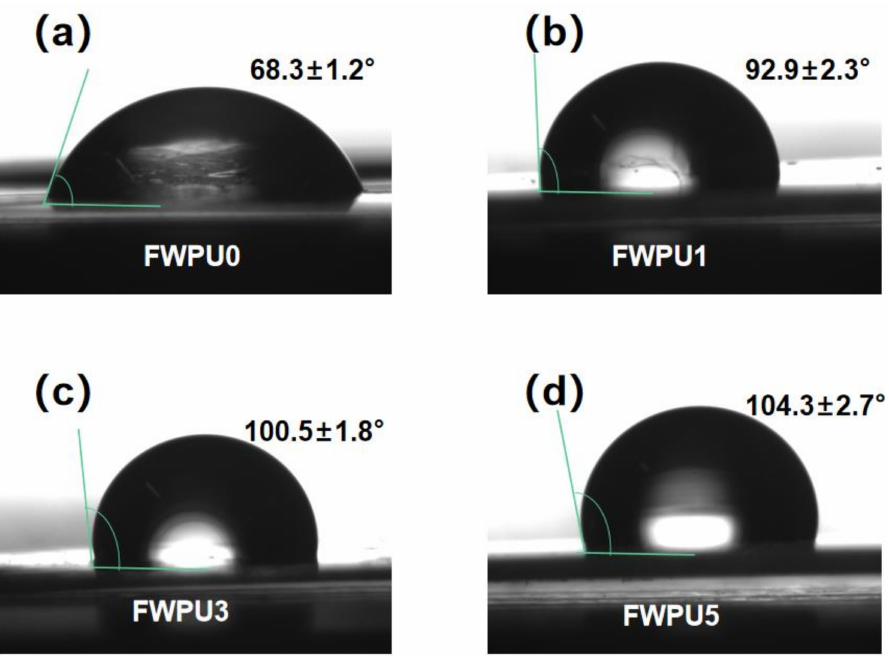
Figure 4. The WCA images of the FWPU with different POSS contents, FWPU0 ( a ), FWPU1 ( b ), FWPU3 ( c ), FWPU5 ( d ).